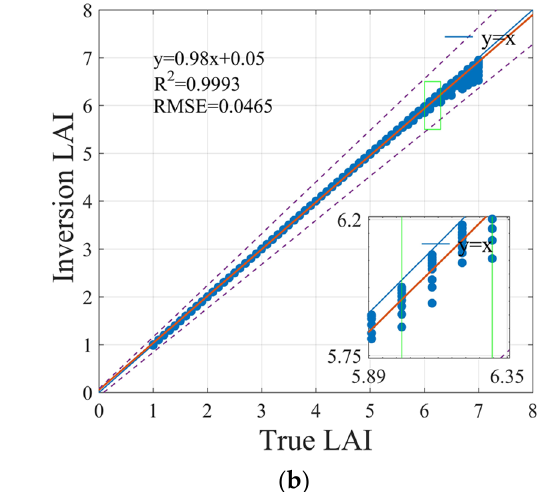
Figure 9. Validation of the Cab and LAI with the OE-iteration method: ( a ) validation of the Cab with the OE-iteration method against the true value under different observation geometries and ( b ) val- idation of the LAI with the OE-iteration method against the true value under different observation geometries. The blue solid line, dashed line, and orange solid line are the 1:1 line, error line, and fit line, respectively. The error lines of ( a , b ) are E = x ± 0.02 x ± 0.08 and E = x ± 0.08 x ± 0.08. The statistics of the linear fitting result, including slope, intercept, R 2 , and RMSE, are listed in the upper left corner of each scatter